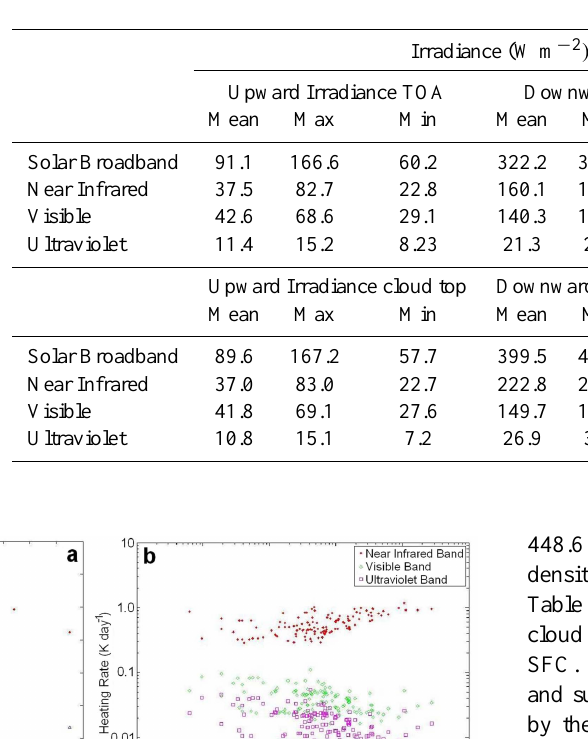
Table 1. Average, maximum and minimum values of upward at TOA and cloud top and downward irradiances at SFC and cloud base. In the broadband, near- infrared, visible and ultraviolet bands.